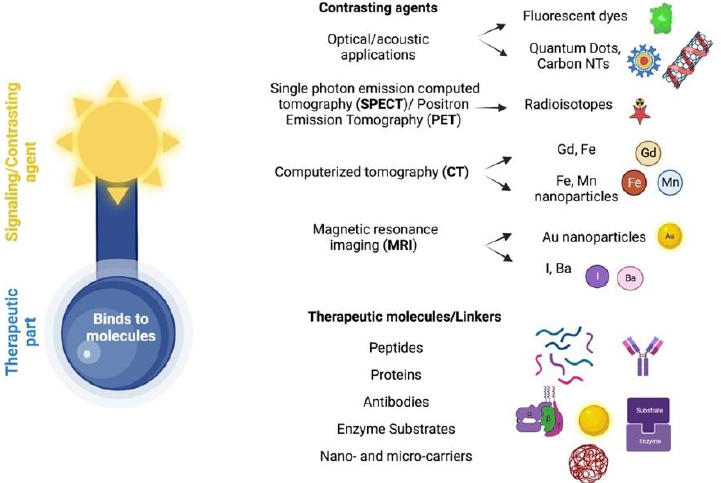
Figure 9. The general structure of theranostic radiopharmaceuticals. Their therapeutic part binds to the molecule while the signaling part or contrasting agents are responsible for their diagnostic ability. Contrasting agents include fluorescent dyes, quantum dots, carbon NTs, radioisotopes, and inorganic particles based on Au, Fe, Mn, Gd, I, and Ba. Therapeutic molecules can be peptides, proteins, antibodies, and enzymes (created with BioRender.com).